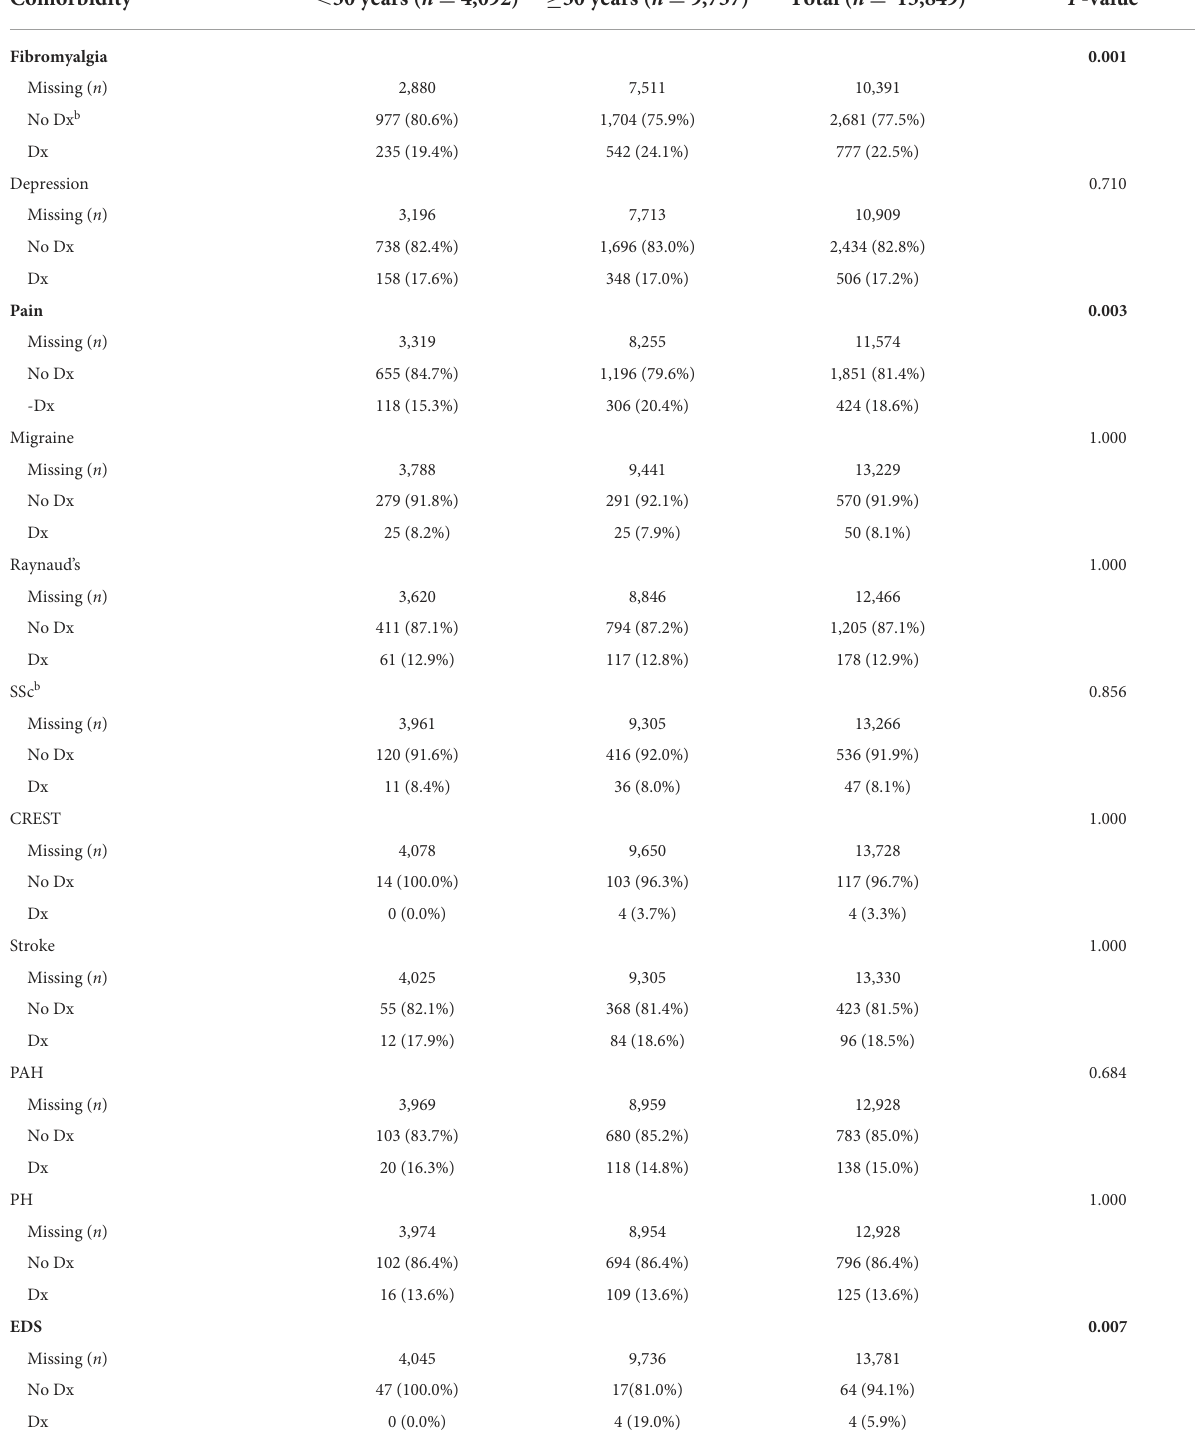
TABLE 8 Likelihood of having comorbidity by age at Sjögren’s disease diagnosis ( n = 13,849). Comorbidity < 50 years ( n = 4,092) ≥ 50 years ( n = 9,757) Total ( n = 13,849) P -value a